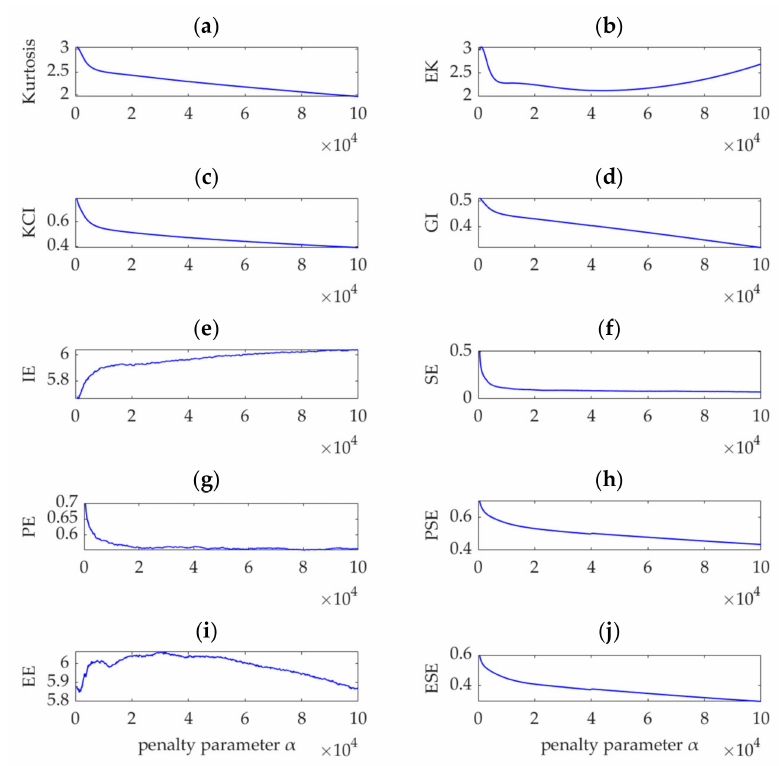
Figure 24. Relationship between different indices and the penalty parameter, α .